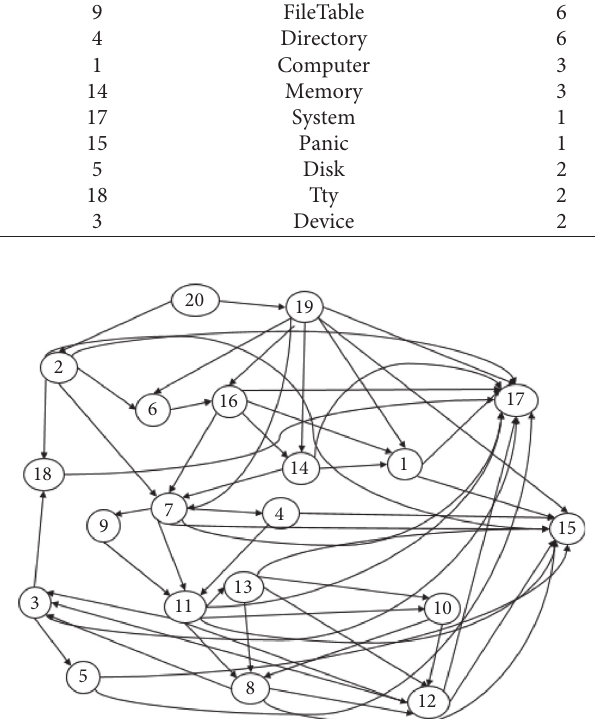
Figure 12: Call dependency graph of Mini-Tunis based on its design documentation